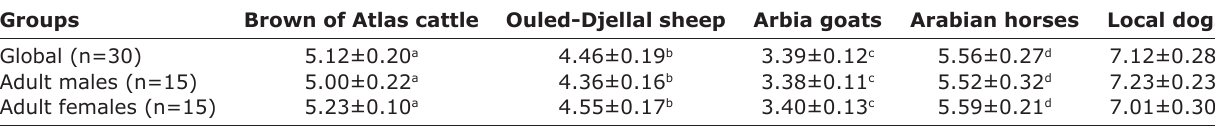
Table-1: Influence of red blood cells diameter on the species determination of pets (Group 1, expressed in μ m). Groups